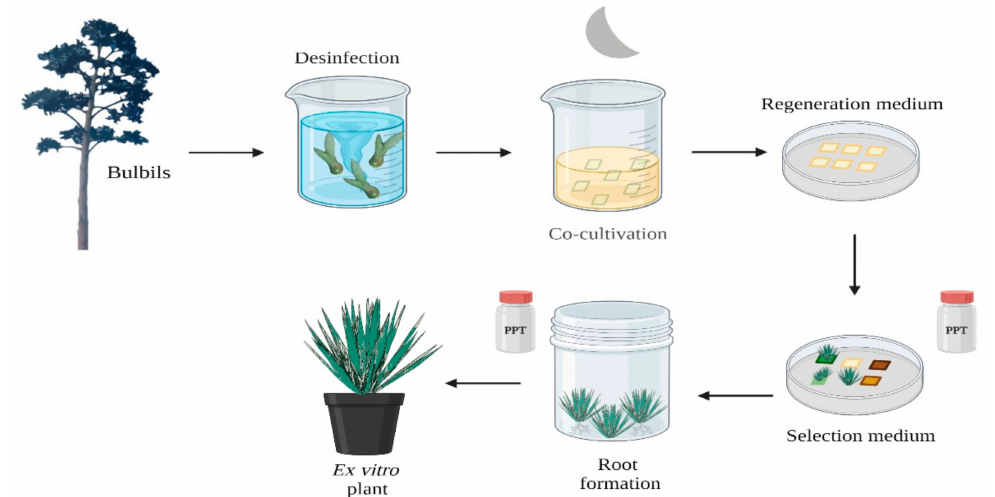
Figure 2. Genetic transformation Protocol. A method for the transformation of A. desmettiana bulbils was established mediated by A. tumefaciens. Shoots were developed by direct organogenesis [48]. Image created with https://app.biorender.com (accessed on 14 February